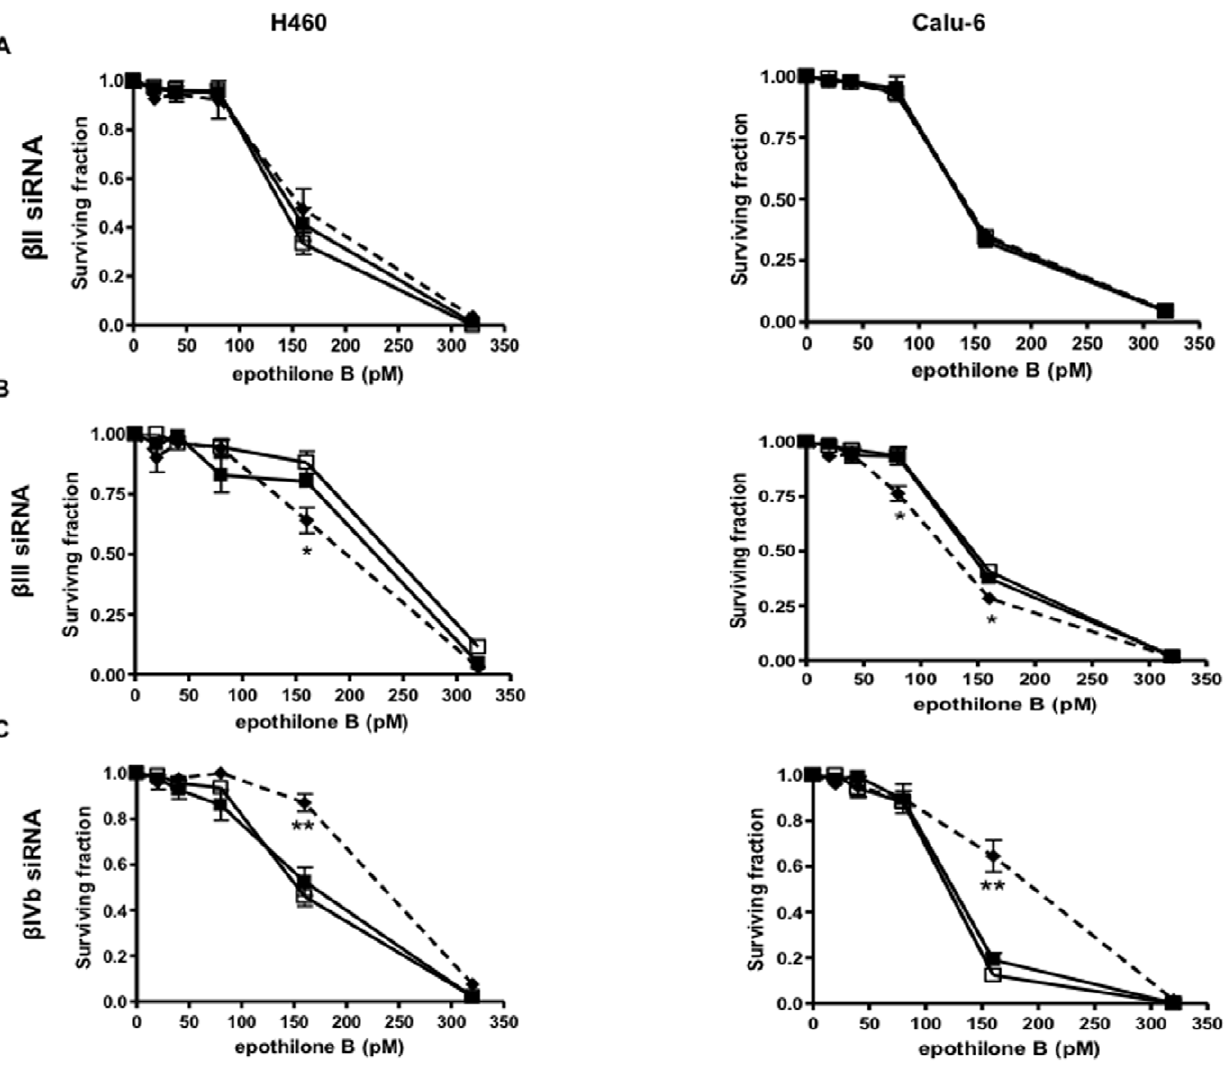
Figure 1. Drug-treated clonogenic assay. Clonogenic assays were performed on mock (closed squares, solid line), control siRNA (open squares, solid line) and specific b -tubulin isotype siRNA-transfected cells (closed diamonds, broken line) in two NSCLC cell lines, H460 (left panel) and Calu-6 (right panel). The graphs show the clonogenic survival of (A) b II-tubulin; (B) b III-tubulin and (C) b IVb-tubulin knockdown cells exposed to epothilone expressed as surviving fraction. Bars, mean 6 SEM of at least four individual assays. Statistics were calculated by comparing the surviving fraction of the knockdown cells with the mock-transfected cells at each drug concentration. * P , 0.05, ** P , 0.01.